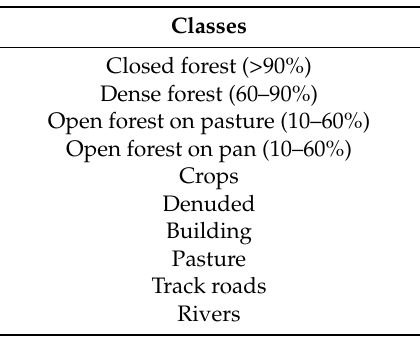
Table 1. Classes of land uses and covers.